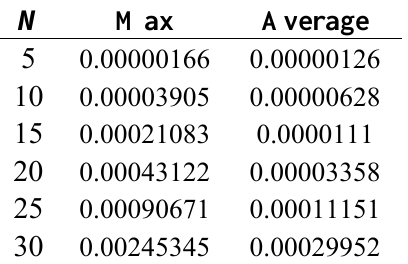
Table 2. Effect of increasing task numbers.